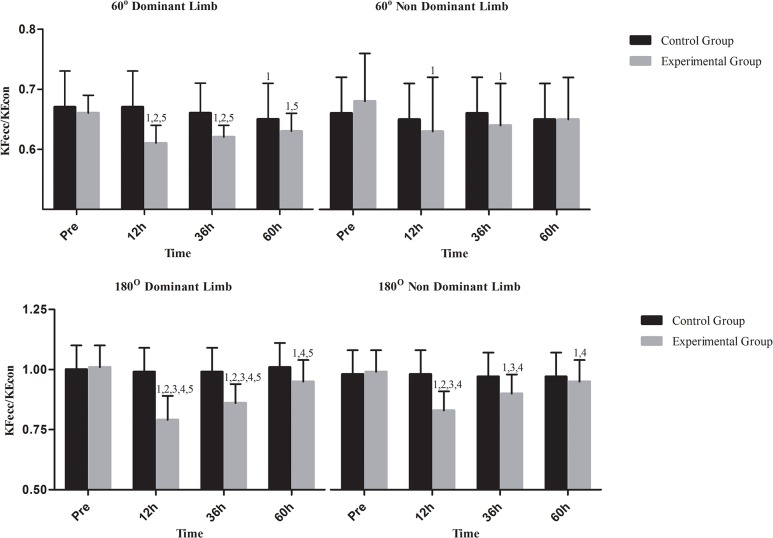
Changes of functional ratio in response to a football match.KFecc/KEcon, functional ratio; h, hours; 1Significant difference with baseline; 2significant difference between groups; 3significant difference between dominant and non-dominant limb at corresponding time; 4greater decline in functional ration compared to conventional ratio at corresponding time;5greater decline at 180°/s compared to that at 60°/s at corresponding time.